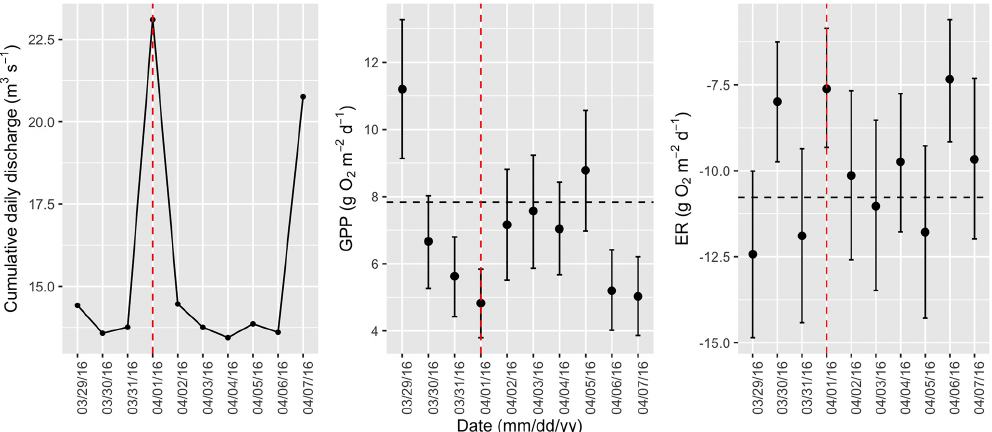
Figure A11. Cumulative daily discharge and metabolism (gross primary production and ecosystem respiration; GPP and ER) time series for the Stroubles Creek flow event on 1 April 2016 (noted with a dashed vertical red line in all three panels). The dashed horizontal black lines are mean values of GPP and ER prior to the high flow event. Error bars for posterior estimates of GPP and ER are 2.5% and 97.5% Bayesian credible